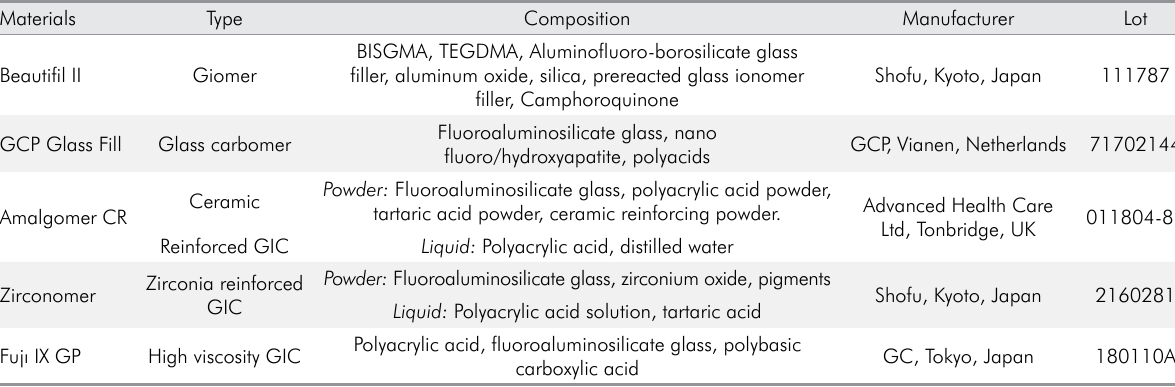
Table 1. Composition of the materials according to the manufacturers’ data.